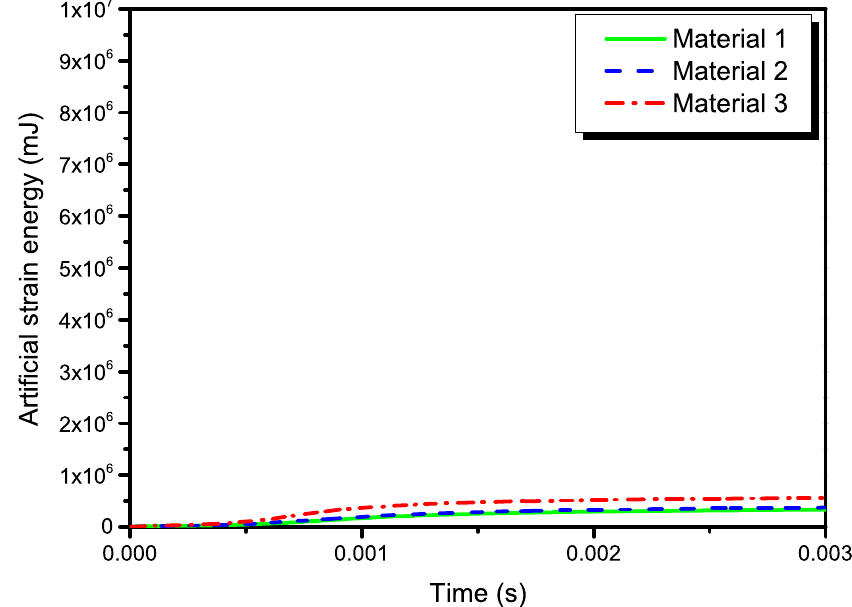
Figure 17. Time histories of the artificial strain energy in the three models.